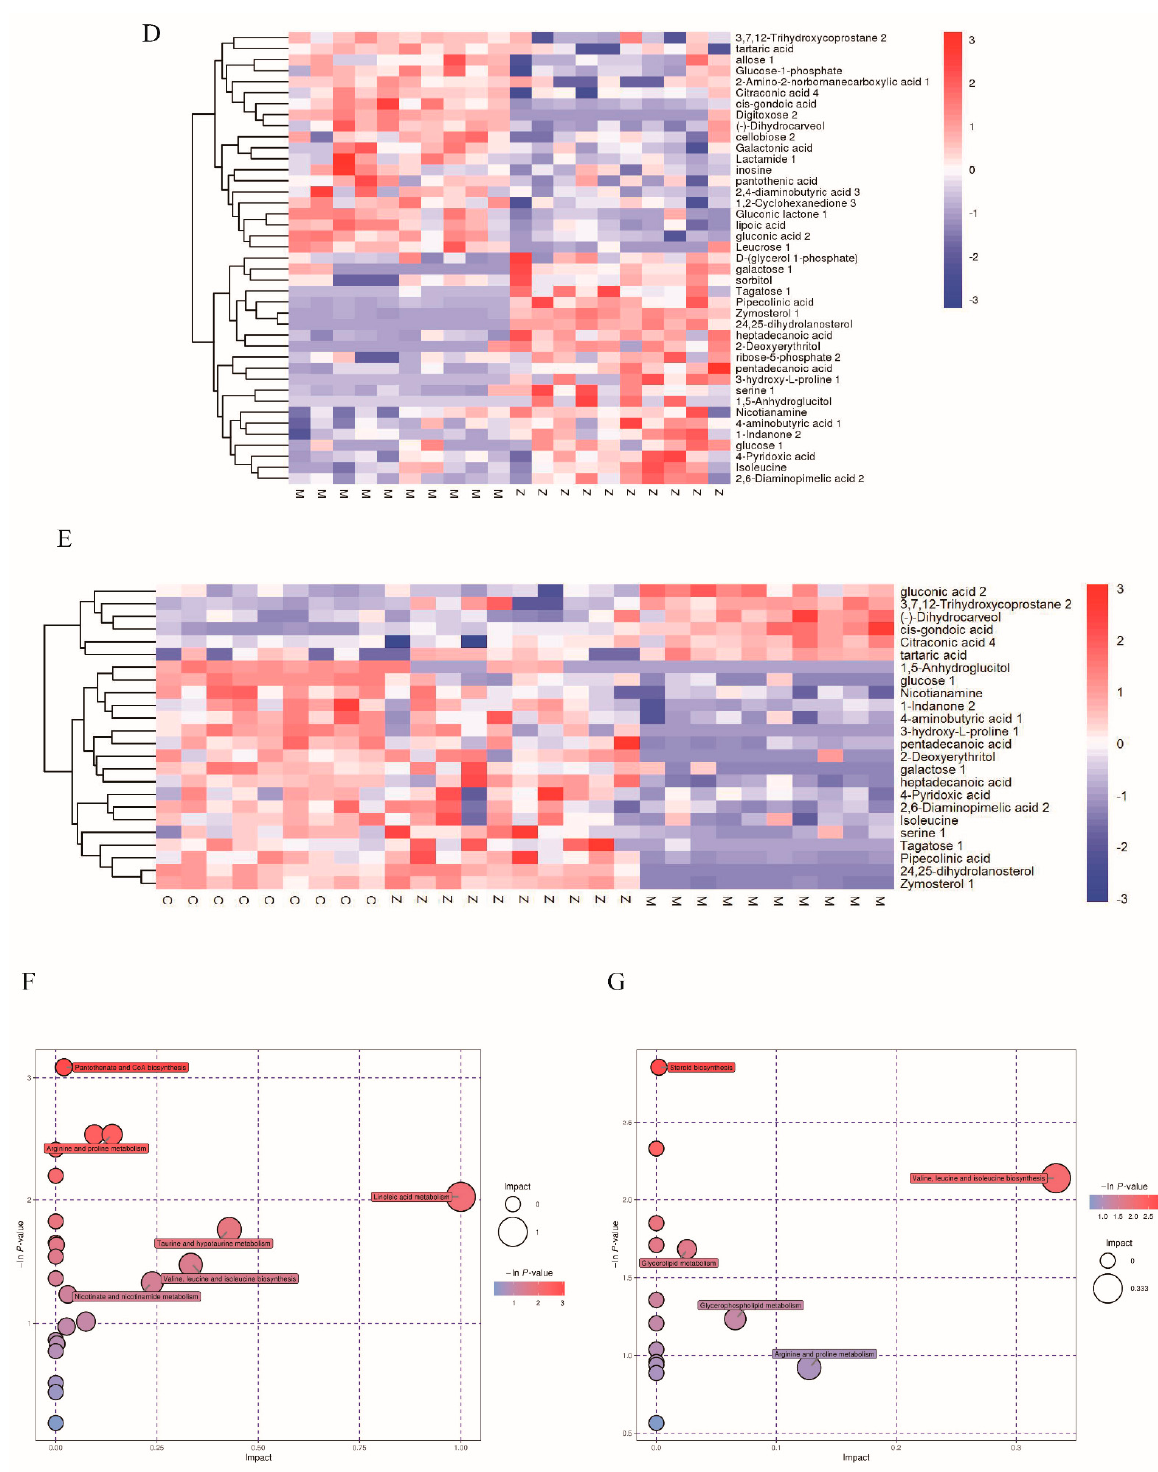
Figure 8. Volcano plot analysis for ( A ) group M vs. C and ( B ) group Z vs. M. Heatmap of hierarchical clustering analysis for ( C ) group M vs. C and ( D ) group Z vs. M. Heatmap of hierarchical clustering analysis among ( E ) group M vs. C and Z. Pathway analysis for ( F ) group M vs. C and ( G ) group Z vs.